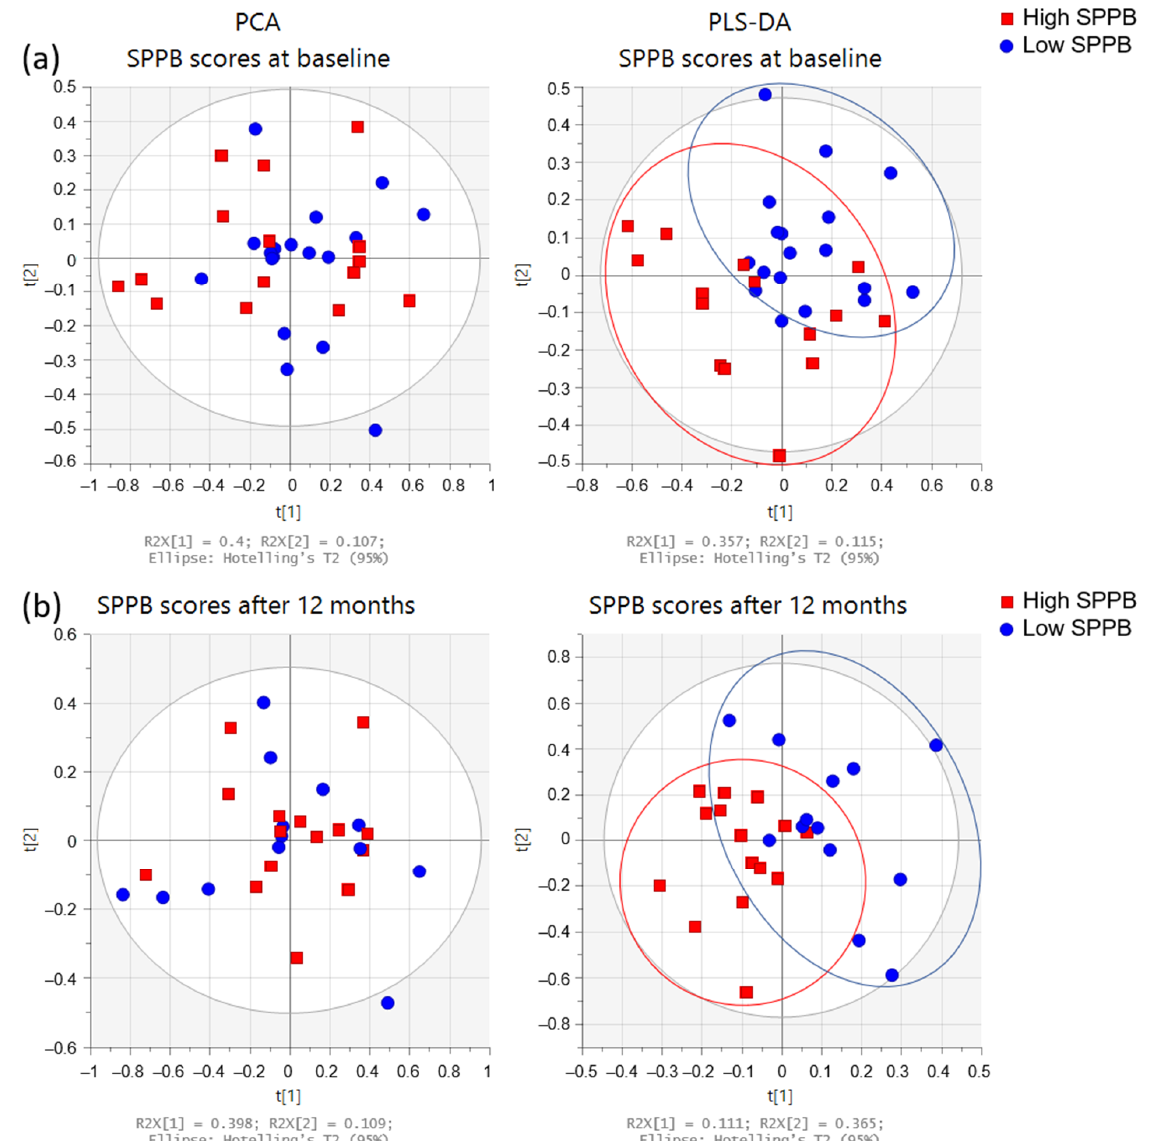
Figure 6. Multivariate analysis of the urine spectra of the participants’ SPPB (n = 33). Score plots from PCA ( left side) and PLS-DA ( right side): ( a ) at baseline (low ≤3 (n = 18); high >3 (n = 15)), and ( b ) after 12 months (low ≤8 (n = 13); high >8 (n = 15)). SPPB groups were dichotomized with medians: high SPPB (red squares) and low SPPB (blue circles).